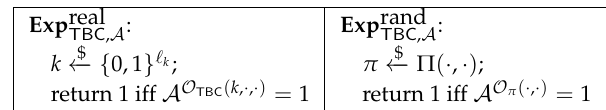
Figure 4. Experiments for the tweakable block